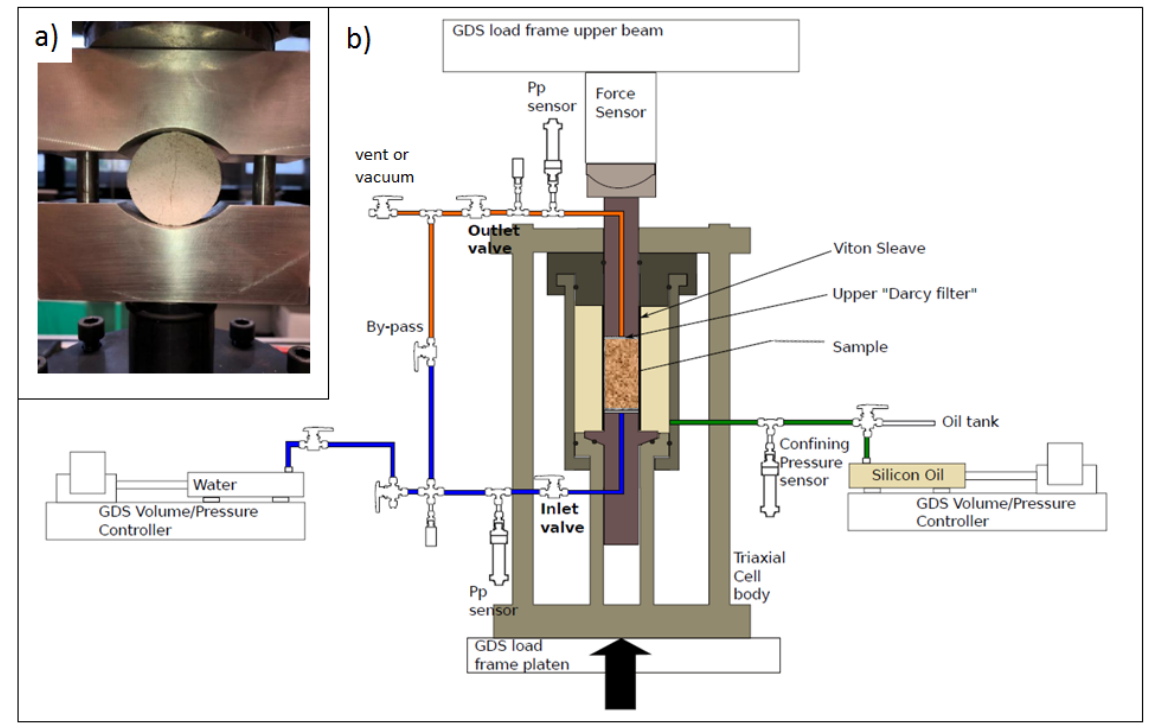
Figure 2. ( a ) Device used for conducting Brazilian tests for the determination of the tensile strength. ( b ) Sketch of the setup used for conducting standard triaxial tests and injection tests in a pressure vessel.